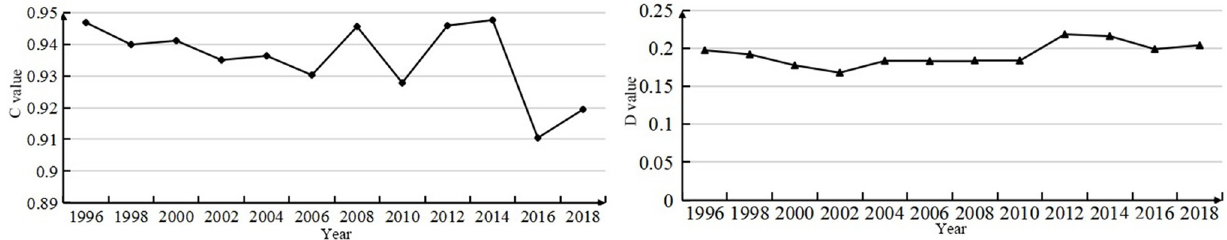
Fig 5. The development trend of the coupling and coordination of PECL in XJC from 1996 to 2018. a The picture on the left shows the development trend of the coupling situation, and the picture on the right shows the development trend of the coupling coordination